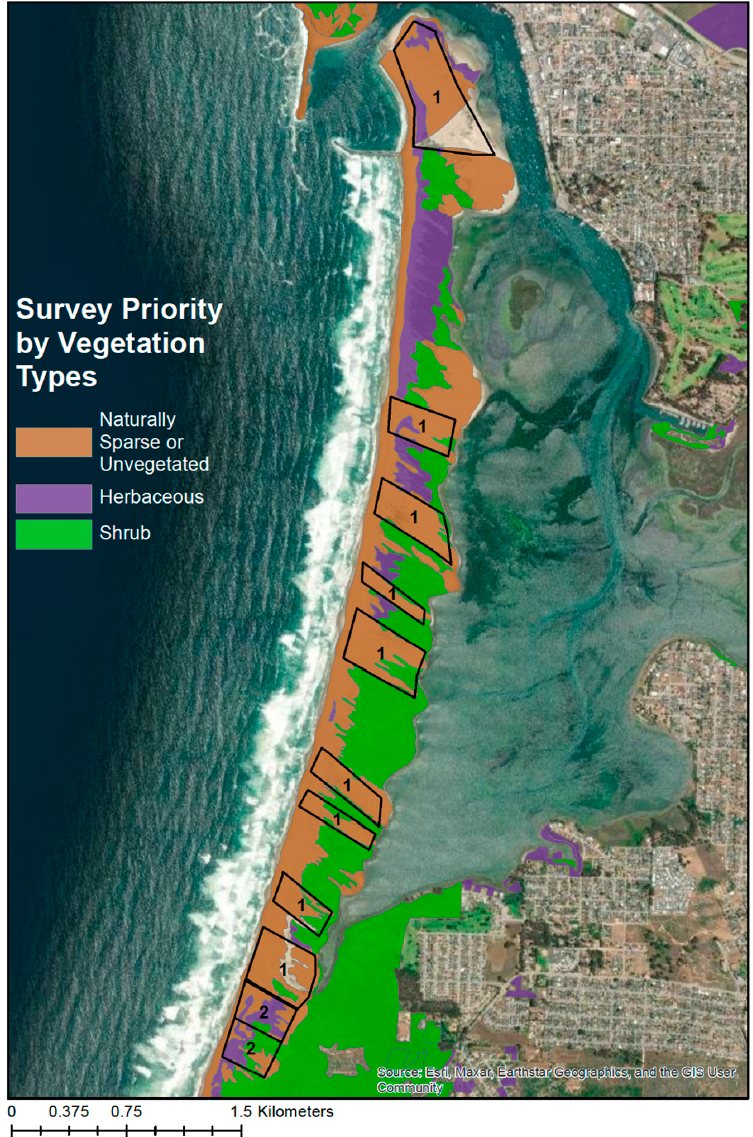
Figure 2. Map of the Morro Bay sandspit, Morro Bay, California, showing vegetation types and individual survey polygons. Polygons labeled ‘1’ were prioritized search areas due to being mostly naturally sparse and unvegetated. The northern most polygon ‘1’ was not surveyed and was disqualified after considering its location at the tip of a peninsula and the degree of rock contributing to the sandy soil. Instead, two polygons (labeled as ‘2’) composed of herbaceous cover were surveyed given their location at that base of the peninsula and as they still contained sparsely vegetated areas. The vegetation type layer was provided by the California Department of Parks and